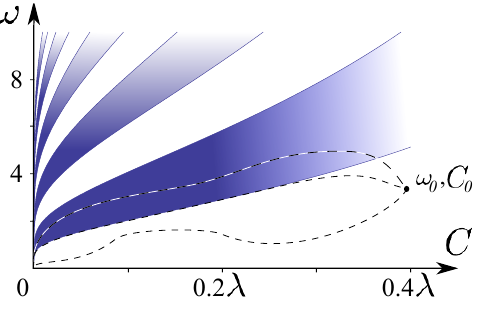
Figure 10 . Regions (cid:1) I 3 > 0 (white) and (cid:1) I 3 < 0 (blue) in the ( C; ! ) plane. We use the solution (4.4) with A 2 = 12e (cid:0) 2 (cid:30) 0 =(cid:21) 2